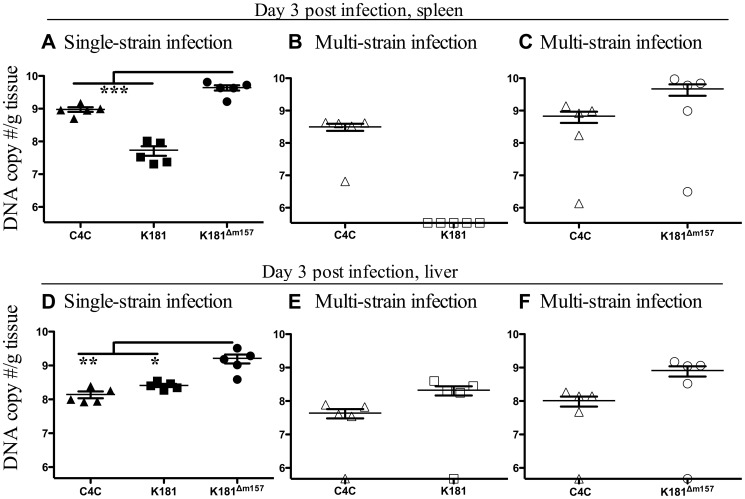
Competition is evident early, before the maturation of acquired immunity.B6 mice were inoculated i.p. with 1×104 pfu of either C4C, K181 or K181Δm157 (closed symbols) or a total of 1×104 pfu of a mixed inoculum of equal proportions of with C4C and K181 or C4C and K181Δm157 (open symbols). A. Viral DNA levels in the spleens of B6 mice three days after single strain infection. B. Viral DNA levels in the spleens of mice co-infected with C4C and K181. C. Viral DNA levels in the spleens of mice co-infected with C4C and K181Δm157
D. Viral DNA levels in the livers of B6 mice three days after single strain infection. E. Viral DNA levels in the livers of mice co-infected with C4C and K181. F. Viral DNA levels in the spleen of mice co-infected with C4C and K181Δm157. Note competition was evident in the spleen (B) but not in the liver (E). Data are mean ± SEM for 5 animals per group. Dotted line indicates limit of detection. DNA levels in mice following single strain infection were compared by one-way Anova, asterisks indicate level of significance after Tukey's post hoc analysis (*** P<0.001, ** P<0.01, * P<0.05).